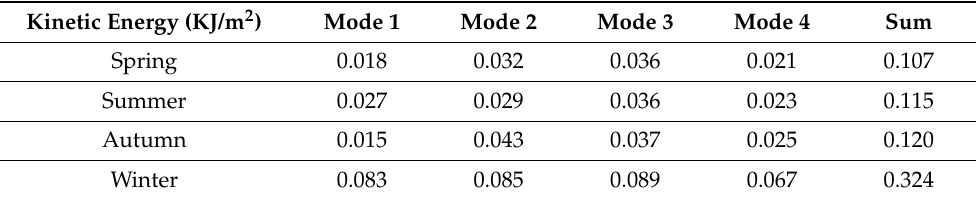
Figure 11. Time series of the depth-integrated NIKE for the first four modes. The values in the brackets indicate the percentage of the corresponding modal NIKE in the total NIKE (the sum of the four modes) during the entire observation period. Table 2. Time-averaged NIKE in the four seasons.